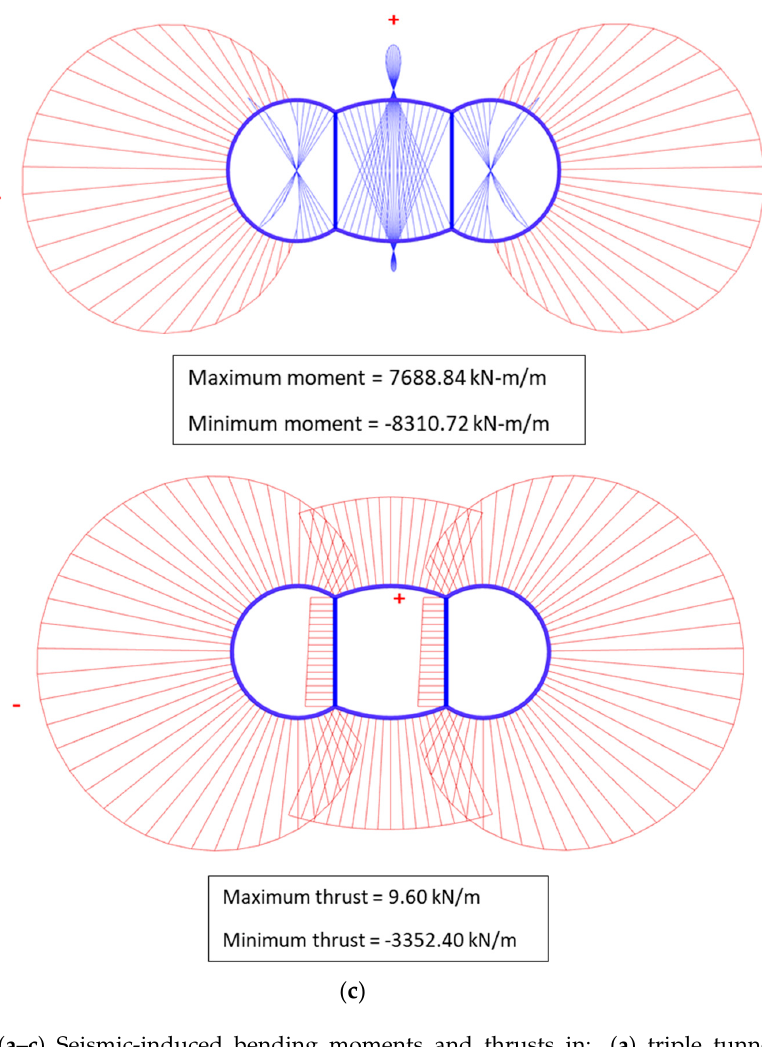
Figure 9. ( a – c ) Seismic-induced bending moments and thrusts in: ( a ) triple tunnel complex, ( b ) rectangular tunnel complex, and ( c ) equivalent twin tunnel complex.